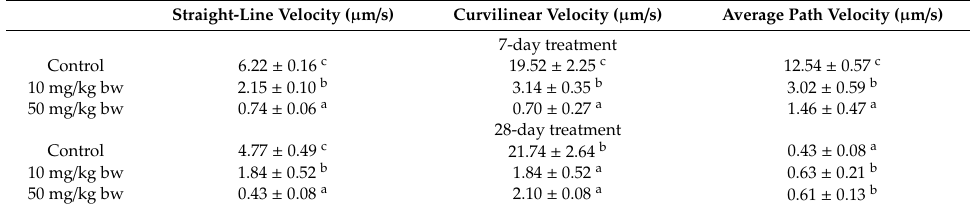
Table 6. E ff ects of sub-dermal administration of Ag-NP on sperm kinematics in male rats. Straight-Line Velocity ( µ m / s)